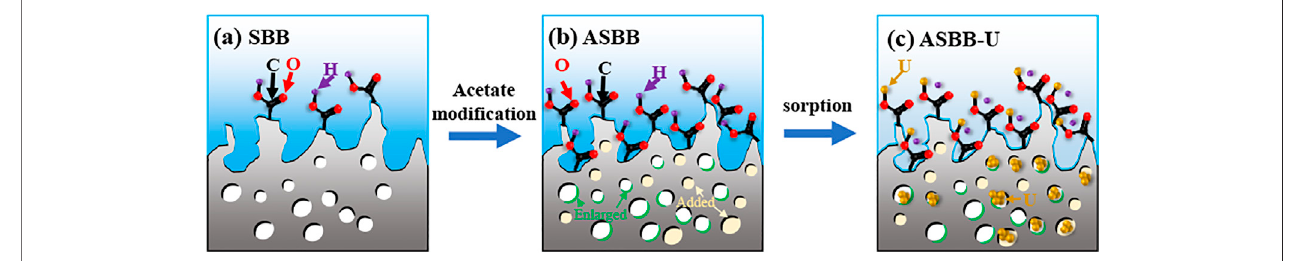
FIGURE 7 | Schematic diagram of SBB modi fi cation and uranium adsorbed by ASBB. (A) SBB, (B) ASBB, (C)